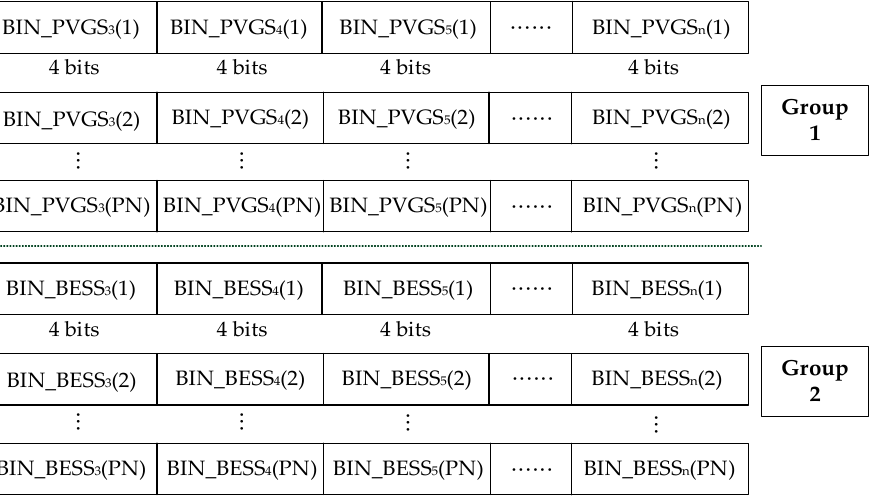
Figure 1. Genes on the chromosome strings.